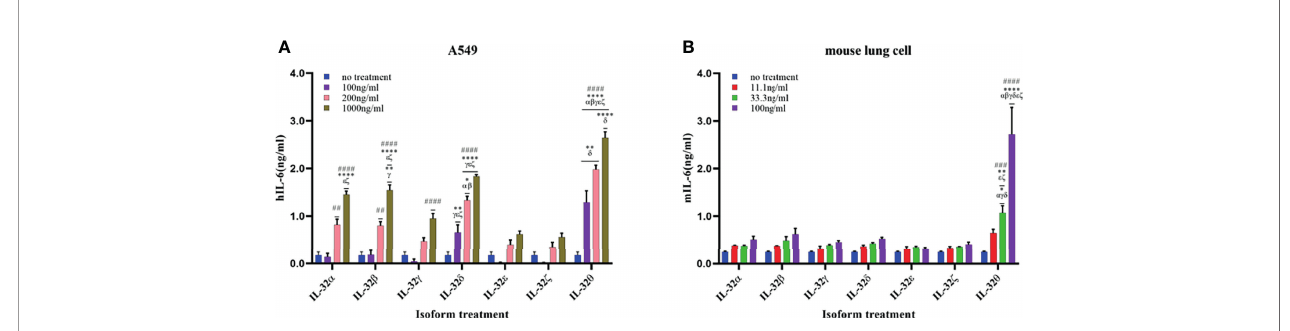
FIGURE 6 | Biological activities of seven rIL-32 isoforms in lung cells. rIL-32 isoforms with different concentrations were treated for 18 h in human A549 lung cells (A) and primary mouse lung cells (B) . IL-6 production was measured by ELISA. The bar graph represents the level of cytokines, mean ± SEM. Statistical testing was performed using two-way ANOVA, followed by Tukey ’ s post-hoc analysis. ## p < 0.01, ### p < 0.001, #### p < 0.0001 as compared to no-treatment control within the same isoform treatment. * p < 0.05, ** p < 0.01, **** p < 0.0001 as compared to other displayed isoform symbols treated with the